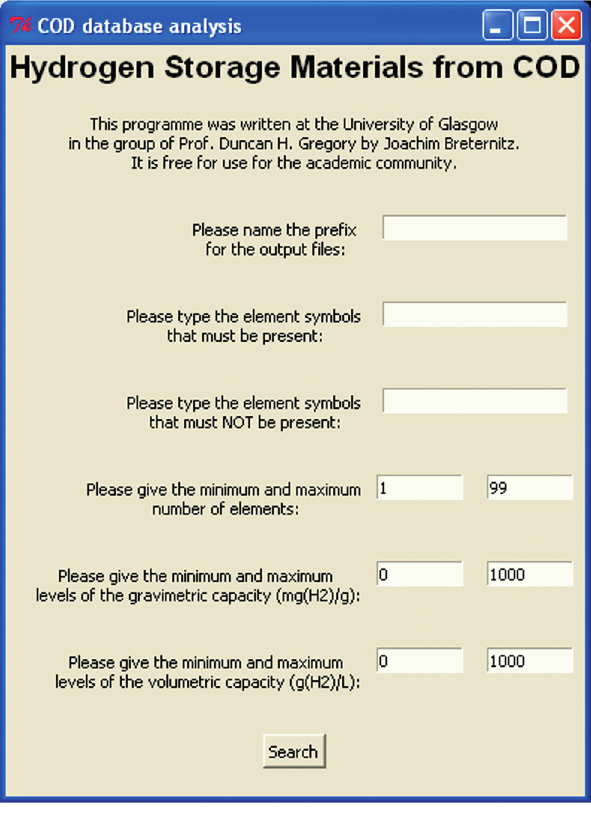
Figure 1. Screenshot of the graphical user interface (GUI) for the search program interface (with the default values